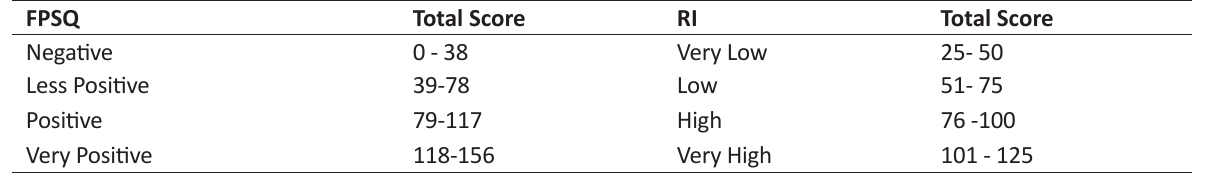
Table 4. Classification of the